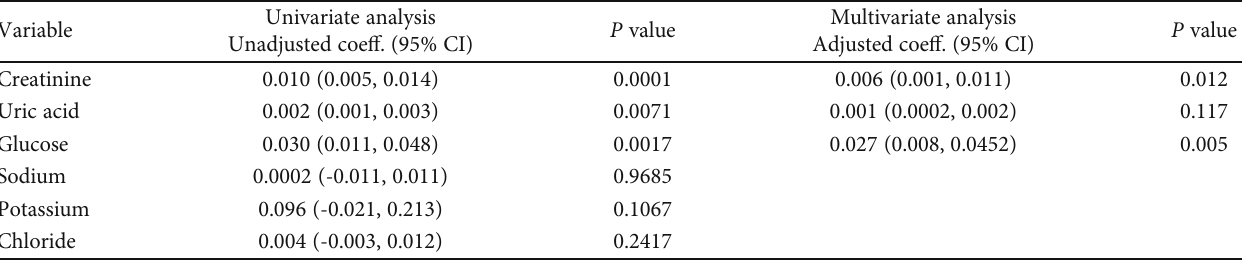
Table 4: Univariate and multivariate analysis for potential association showing the relationship between microalbuminuria and the traditional serum